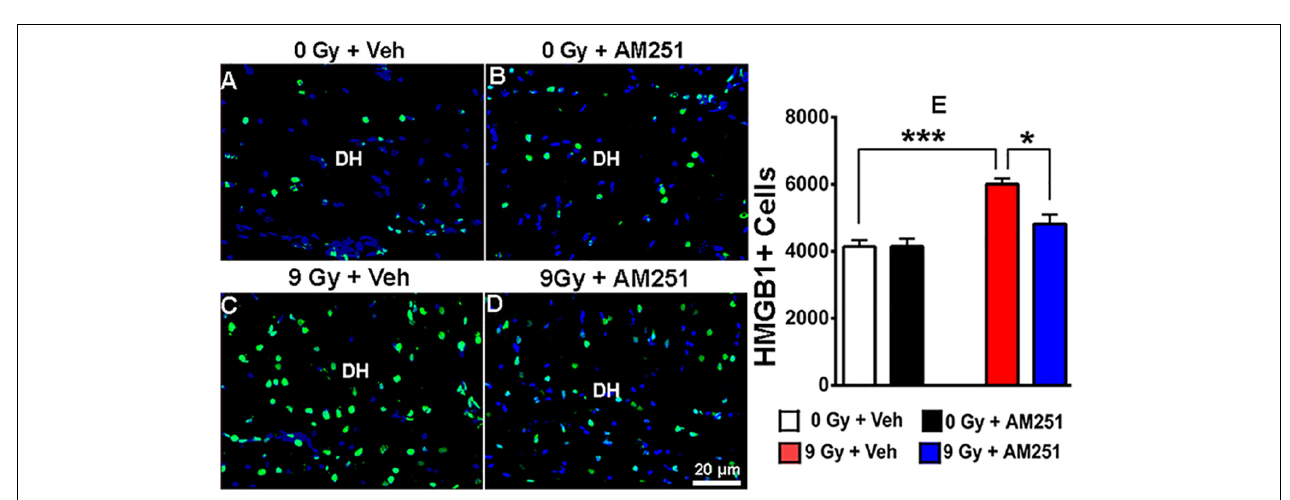
FIGURE 5 | AM251 protects hippocampal neurogenesis and preserves the number of mature neuron (NeuN +) in the irradiated hippocampus of mice: Neurogenesis: Representative confocal images showing BrdU + cells (red staining) with NeuN (green staining) coexpression (A1–A4) . At 19 weeks postirradiation, significant radiation-induced reductions in the number BrdU + /NeuN + neurons were observed, an effect that was ameliorated by long-term AM251 treatments (A5) . Stereology: Brightfield images show the distribution of NeuN + neurons (black staining) in the GCL (B1–B4) and CA1 (C1–C4) subfields of the hippocampus among treatment groups. Quantification at 19 weeks postirradiation demonstrated a significant loss of NeuN + cells in the GCL of irradiated animals, an effect that was ameliorated in mice that received long-term AM251 treatments (B5) . The number of NeuN + cells in the CA1 was not found to differ significantly among the various treatment groups (C5) . Data are expressed as the mean ± SEM, N = 4. P -values for BrdU + /NeuN derived from two-way ANOVA followed by Bonferroni correction for multiple comparisons. Whereas, t -test was used to analyzed mature neurons in the GCL (B5). ** P < 0.001; *** P < 0.001.